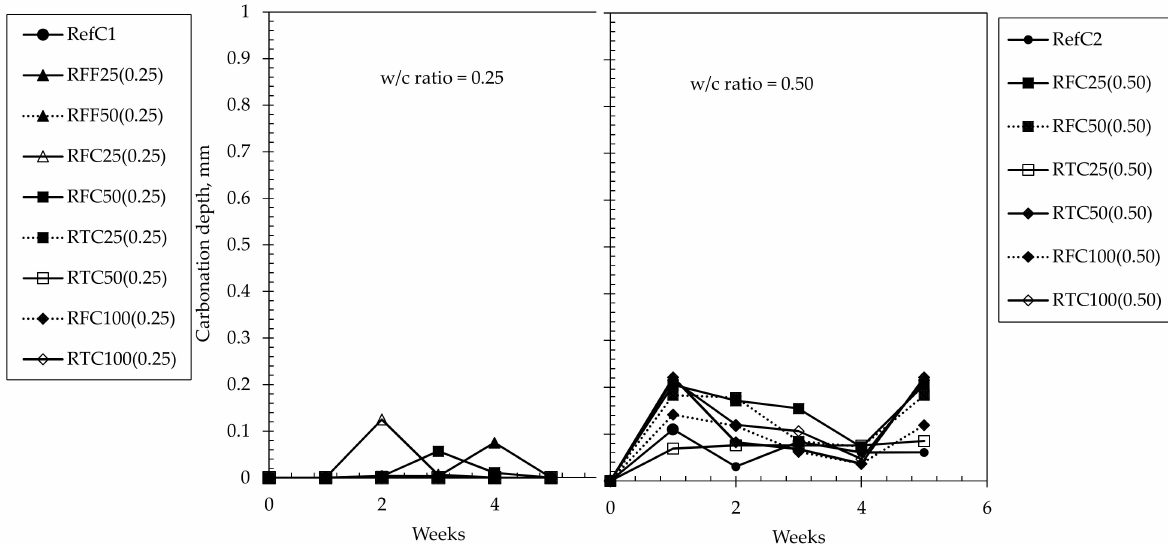
Figure 6. Carbonation depths of concrete mixtures examined up to 5